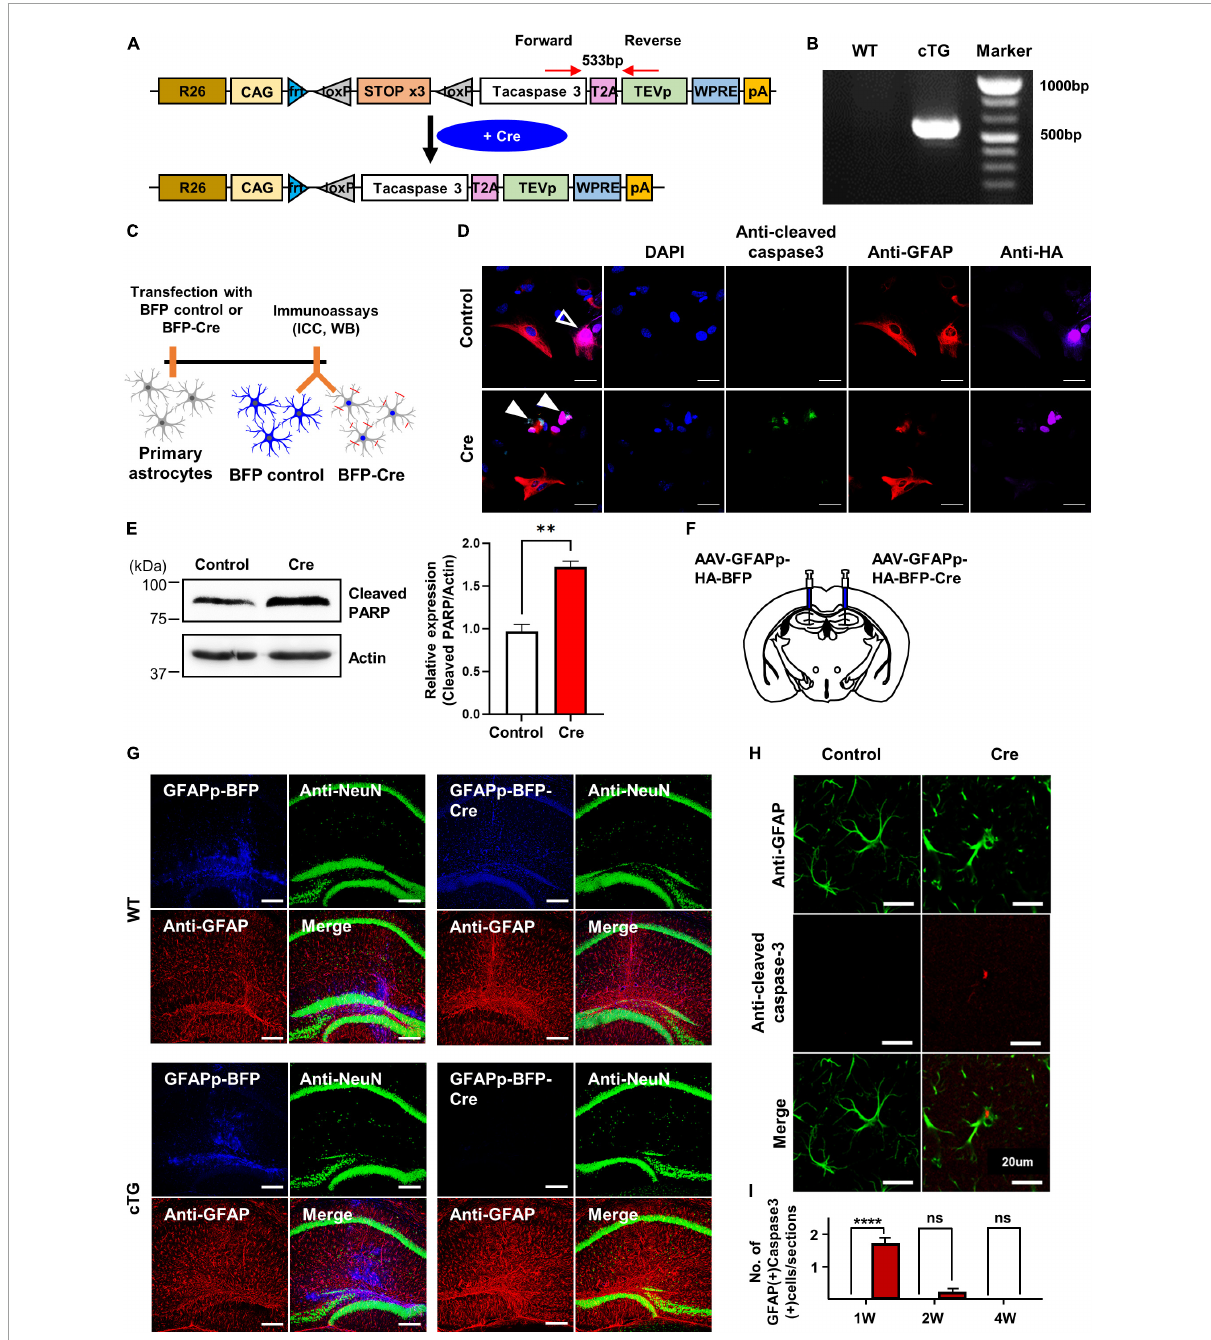
FIGURE1 The generation and validation of active casapse-3 cTg mice. (A) A schematic design of Caspase-3 cTg mice. Inserted genes were designed to express activated caspase-3 with the CAG strong promoter expressed by Cre. (B) Genotype PCR results with designed forward and reverse primer pair. (C) A diagram showing the timeline of in vitro experiment. Cultured primary astrocytes from Caspase-3 cTg mice were electroporated with BFP-control or BFP-Cre construct using NEON kit. (D) Microscopic imaging data indicating the co-localization of GFAP and HA without cleaved caspase-3 in the control group (empty arrow) and co-localization of HA and cleaved caspase-3 without GFAP in Cre group (filled arrow). (E) Western blotting data showing the expression of cleaved PARP, known as downstream of caspase-3 pathway. The amount of cleaved PARP increased by Cre expression. (F) A schematic design showing the injection of AAV-virus containing GFAP promoter, a selective promoter of astrocyte. (G) Microscopic data with no difference in GFAP and NeuN signals between control and Cre virus group in WT mice (upper) and showing the disappearance of viral signal by Cre virus in cTg mice (lower). (H) Microscopic imaging data showing the GFAP without cleaved caspase-3 in the control group and simultaneously an expression of GFAP and cleaved caspase-3 in Cre group. (I) Quantitative data on the number of GFAP-positive and active caspase-3 positive cells from control or Cre group (# of sections =